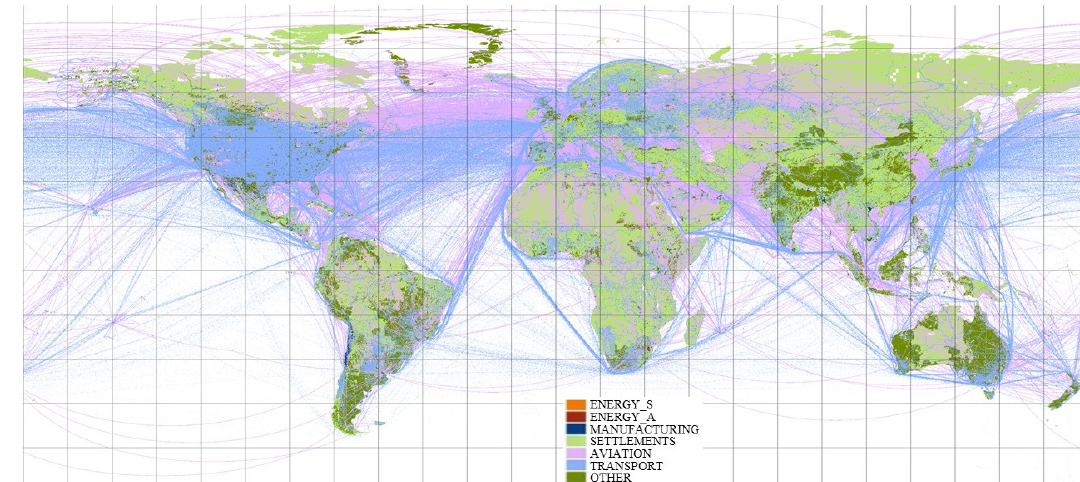
Figure 4. Main emission group that contributes to the total uncertainty per grid cell – global region.